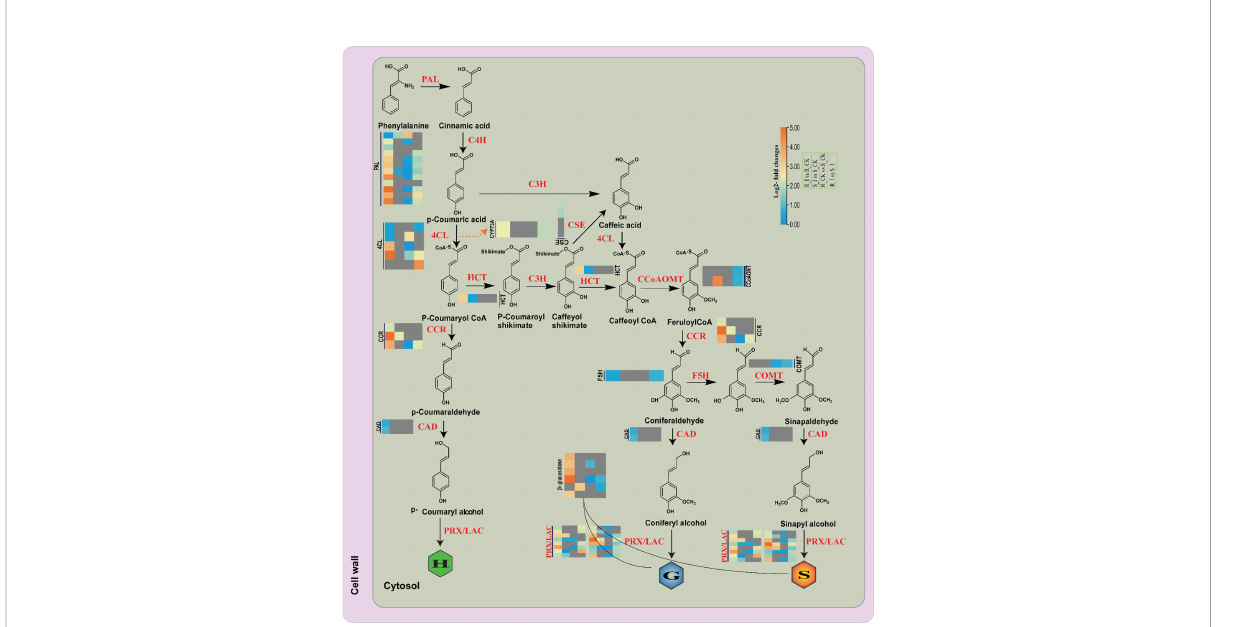
FIGURE 10 Differential expression of genes related with the lignin biosynthesis pathway in different comparison groups of resistance and susceptible watermelon lines during an early stage of PM infection. The Heat map was generated using log2FC, where the red and blue colors specify up- and down-regulated expressions in comparison groups such as R_CK vs. R_I, S_CK vs. S_I, S_CK vs. R_CK and S_I vs. R_I (Left to right/bottom to top). PAL, phenylalanine ammonia-lyase; F5H, coniferaldehyde/ferulate5 hydroxylase; CCR, cinnamoyl-CoA reductase; COMT, caffeic acid/5- hydroxyferulic acid O-methyltransferase; CSE, caffeoyl shikimate esterase; CCoAOMT, caffeoyl-CoAO methyltransferase; C4H, cinnamic acid4 hydroxylase; CAD, (hydroxy)cinnamyl alcohol dehydrogenase; C3 ′ H, p-coumaroyl shikimate3 ′ hydroxylase; 4CL, 4-hydroxycinnamoyl-CoA ligase; HCT, hydroxycinnamoyl-CoA: shikimate/quinate hydroxycinnamoyl